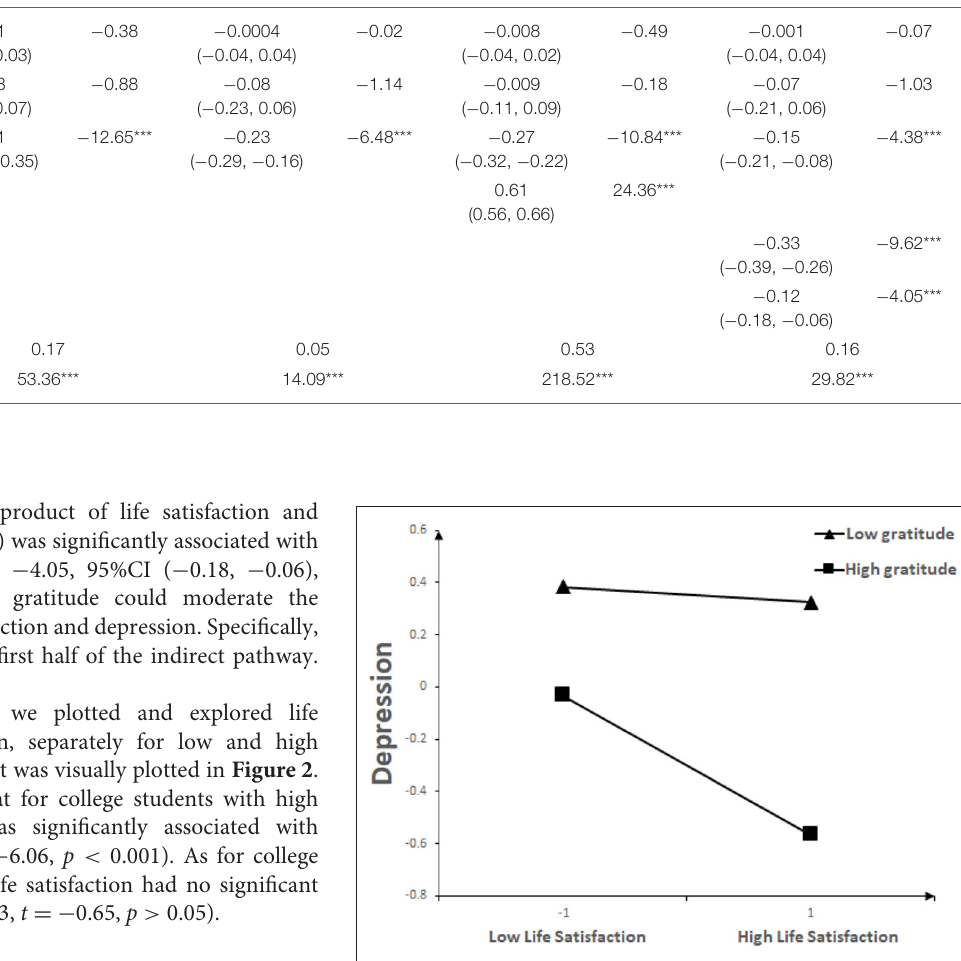
further found that depression played a partial mediating role between life satisfaction and suicidal ideation in college students. Gratitude moderated the relationship between life satisfaction and